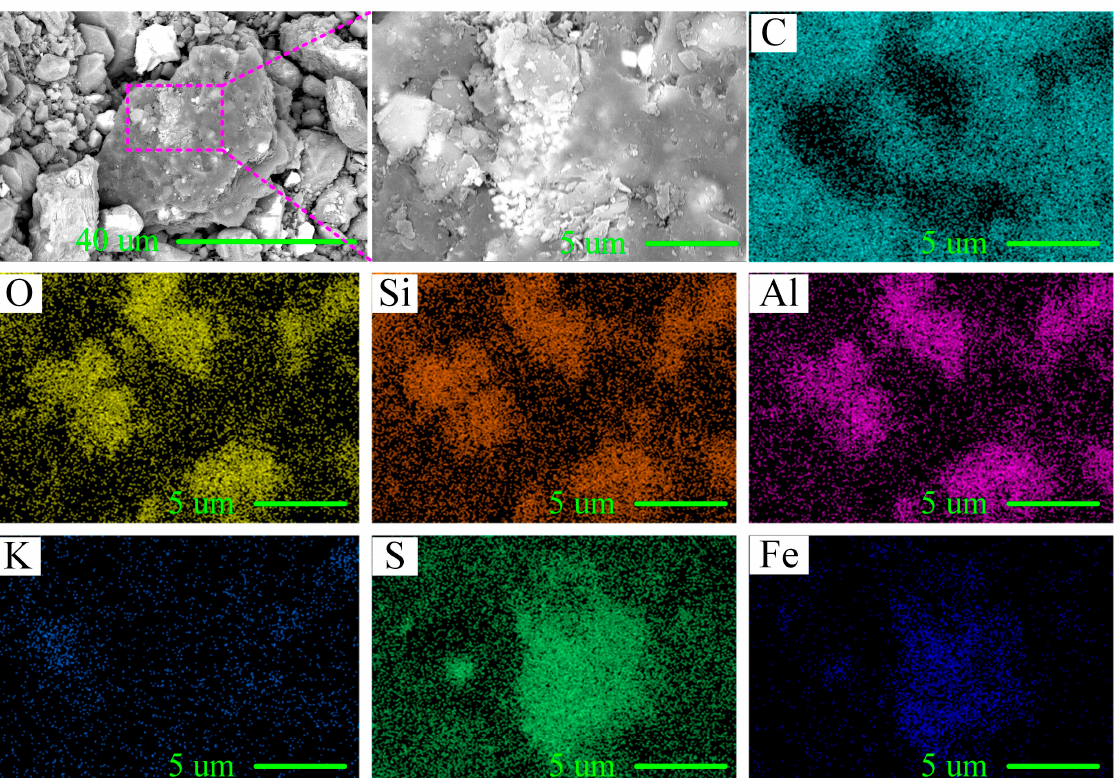
Figure 12. SEM images and EDS results of the raw ore.